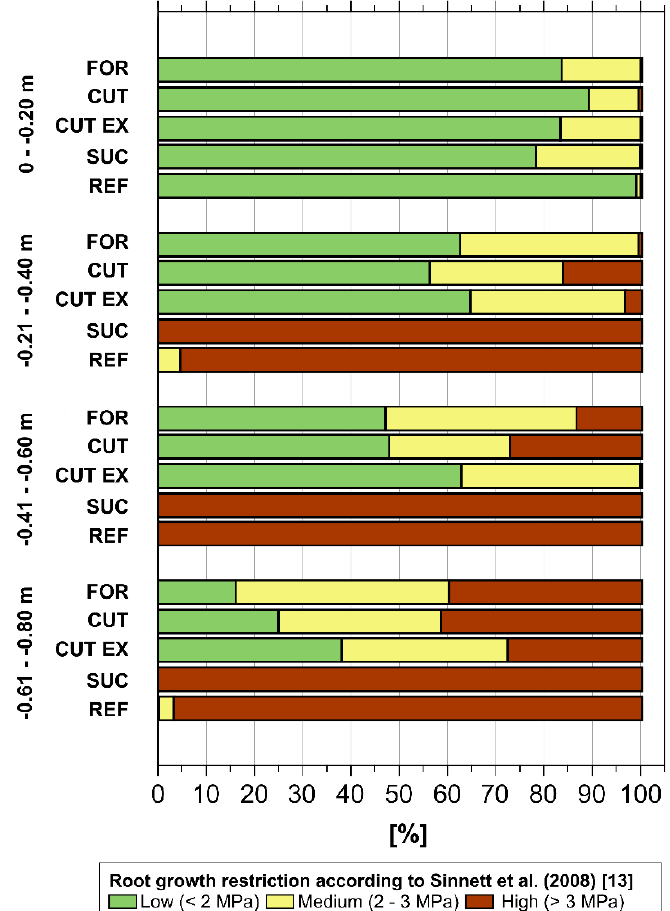
Figure 20. Relative shares of root growth restriction classes according to [13], interpolated datasets.